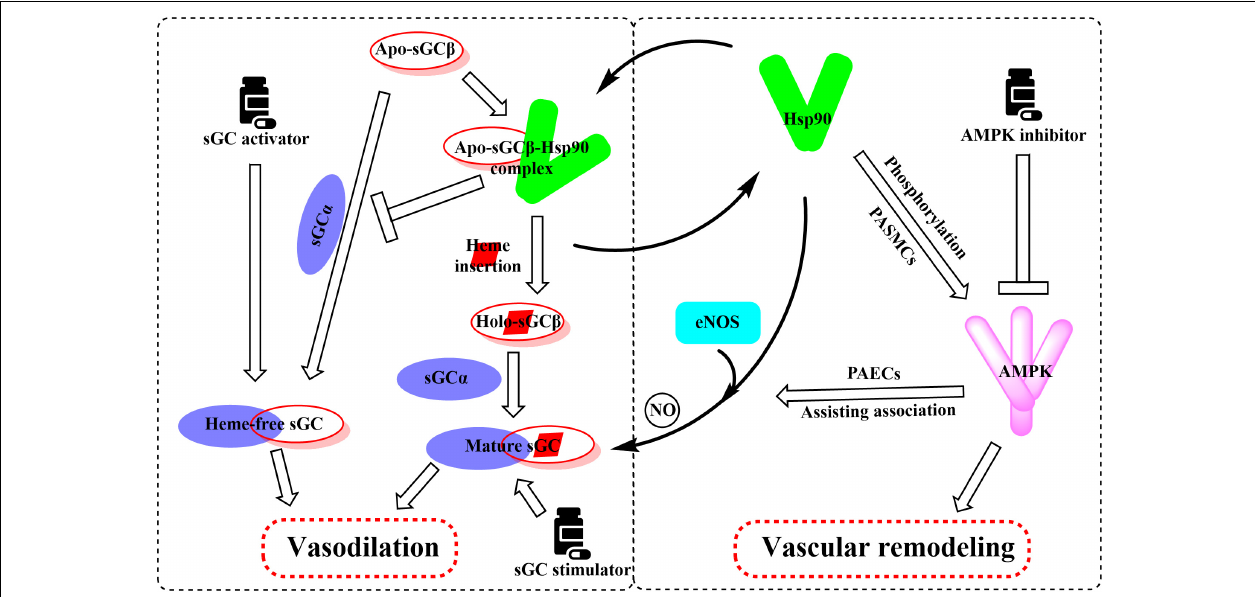
FIGURE 4 | Overview of the important roles of Hsp90 in the regulation of sGC and AMPK involved in the pathogenesis of PAH. Hsp90 drives heme insertion into apo-sGC β after the complex of Hsp90 and apo-sGC β formation. Meanwhile, Hsp90 also prevents apo-sGC β ’s premature interaction with sGC α to form a heme-free, non-functional sGC heterodimer. Hsp90 dissociates from sGC β once heme insertion is complete, allowing holo-sGC β to partner with sGC α and to form a mature and functional sGC heterodimer. AMPK is a client of Hsp90, and Hsp90 interferes with the function of the AMPK complex by mediating the phosphorylation of AMPK in PASMCs. Activation of AMPK in PAECs assists the complex formation between eNOS and Hsp90, promoting eNOS-mediated NO